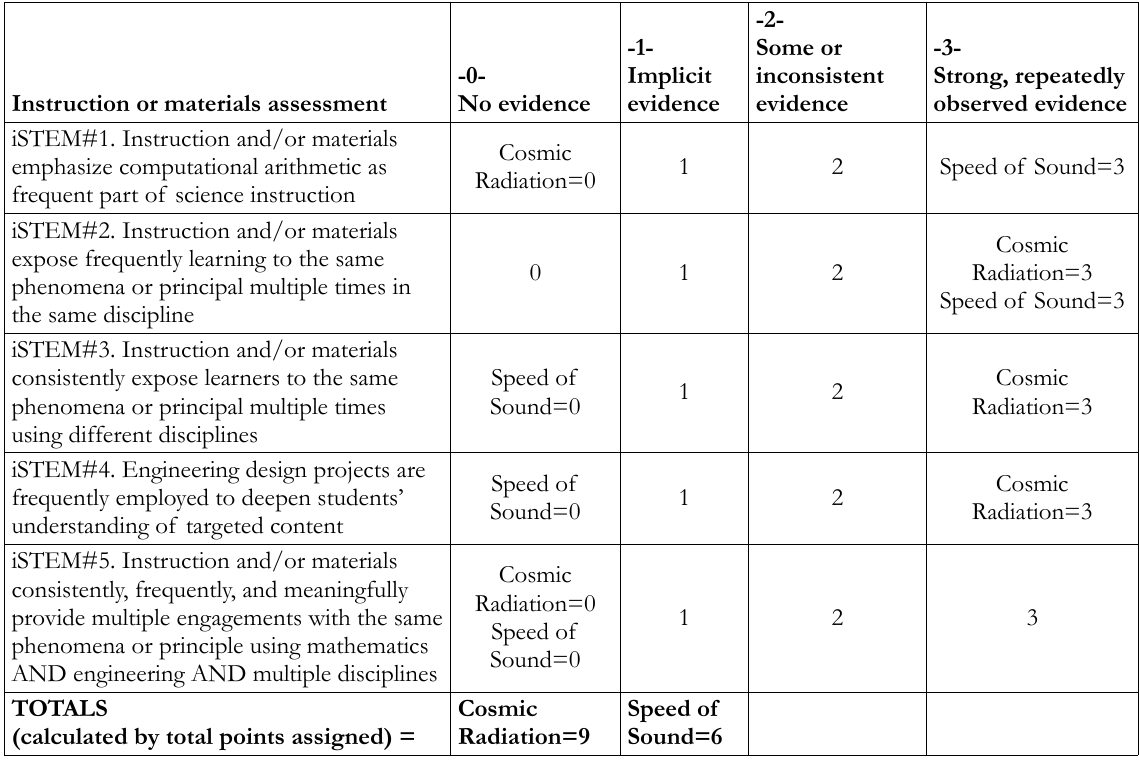
Table 4. An iSTEM-level assessment instrument with team